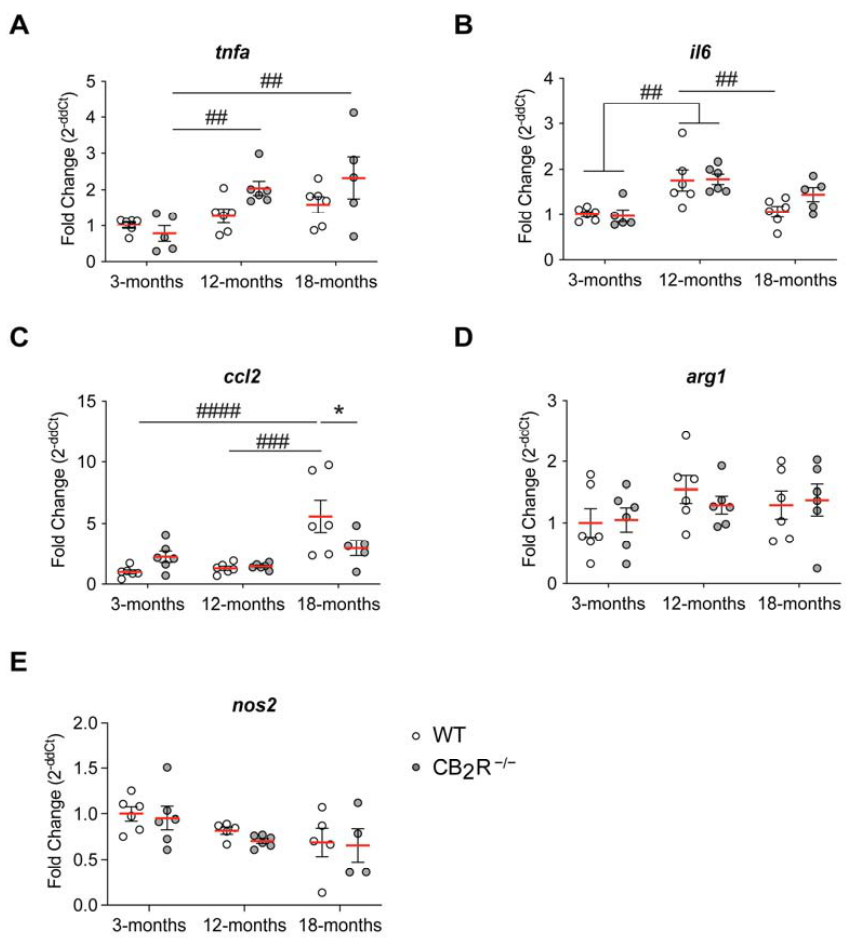
Figure 6. Age-dependent alteration in expression of inflammatory mediators. Expression of tnfa ( A ) and il6 ( B ) in hippocampal tissue increases with age but does not differ between WT and CB 2 R − / − . Expression of ccl2 ( C ) increases with age in WT, but not in CB 2 R − / − . Expression of arg1 ( D ) did not differ between age groups and genotypes, whereas nos2 expression ( E ) decreased with age. WT mice—white circle; CB 2 R − / − mice—grey circles. N = 4–6 mice/genotype/age group. Each point represents a single mouse. Red line indicates the mean value ± SEM. Data were analyzed with two-way ANOVA followed by Sidak’s multiple comparison test, with * p < 0.05, significance between genotypes within the same age group; ## p < 0.01, ### p < 0.001, #### p < 0.0001 significance between age groups within the same